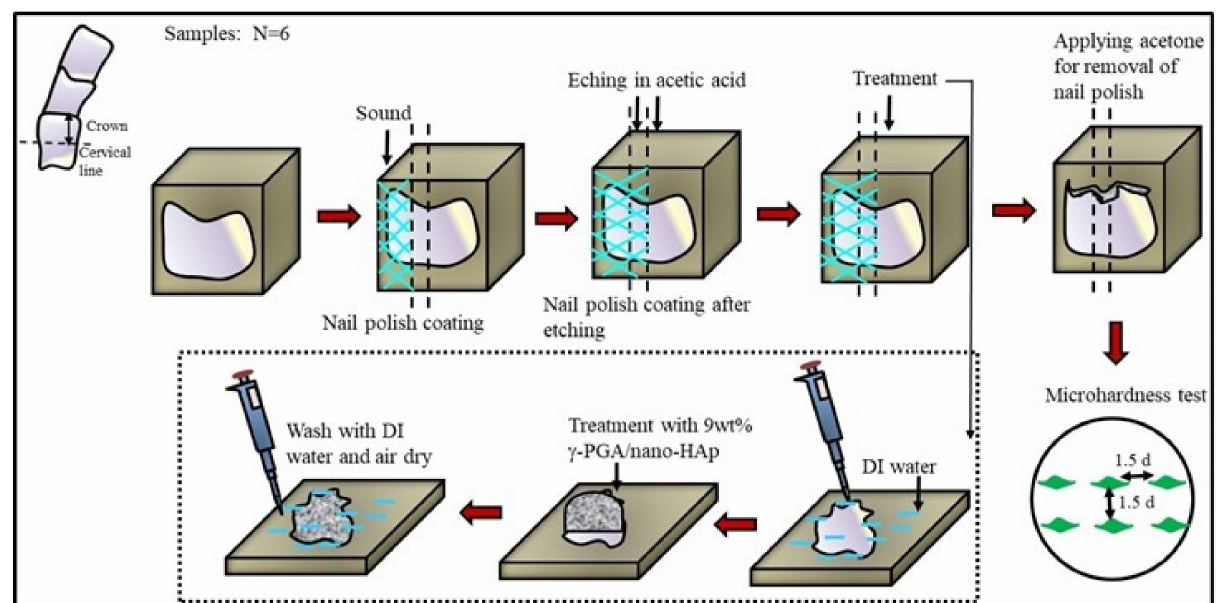
Figure 1. Scheme for demineralization and remineralization of tooth etching, treatment, and microhardness